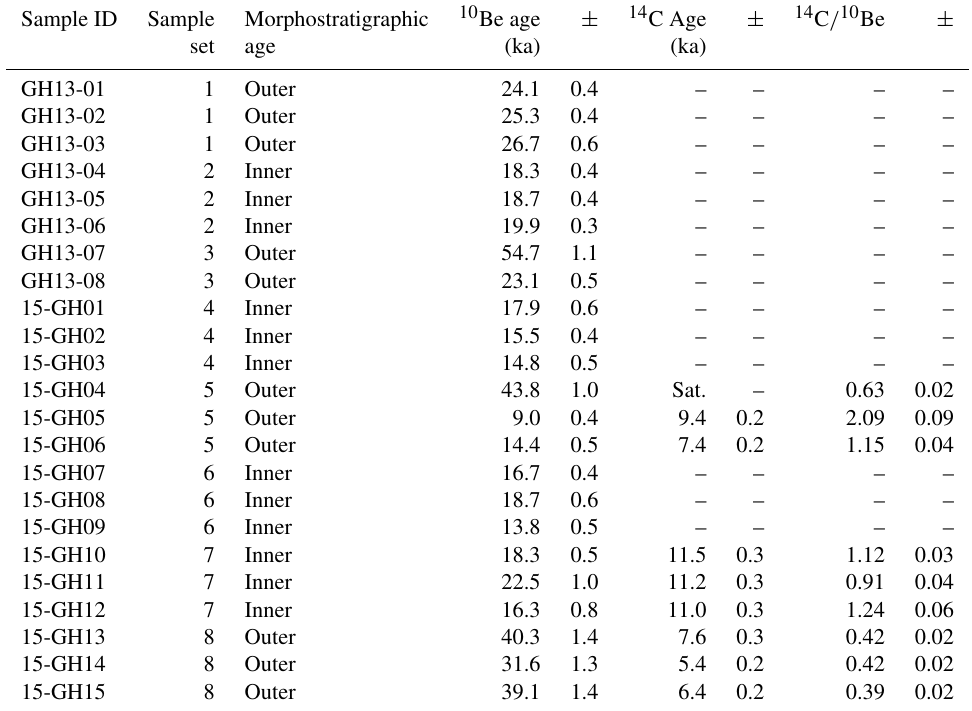
Table 1. Summary table of sample, corresponding sample set, morphostratigraphic age, exposure ages, and 14 C / 10 Be ratios. All uncertainties are presented at the 1 σ level. “Sat.” is the abbreviation for